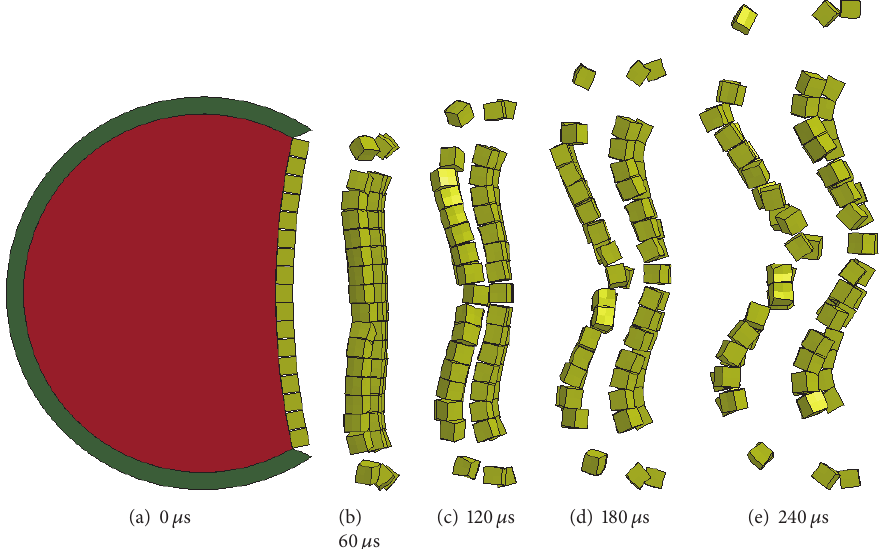
Figure 10: The fragment dispersion process of concave-120 ∘ , 6 r .